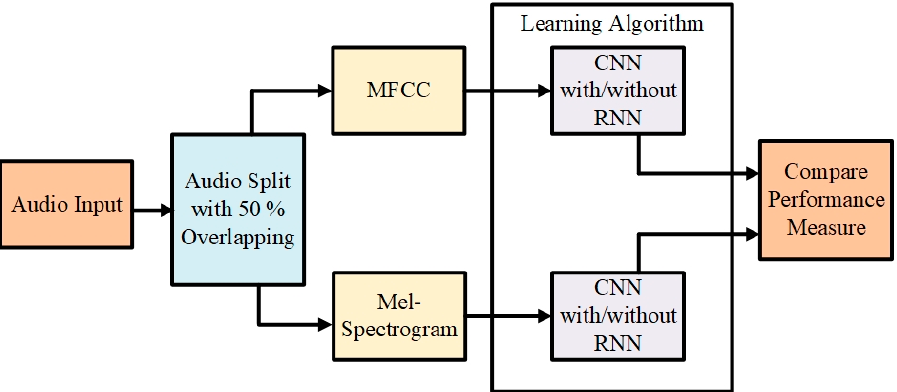
Figure 1. Proposed hybrid architecture with CNN and variants of RNN .